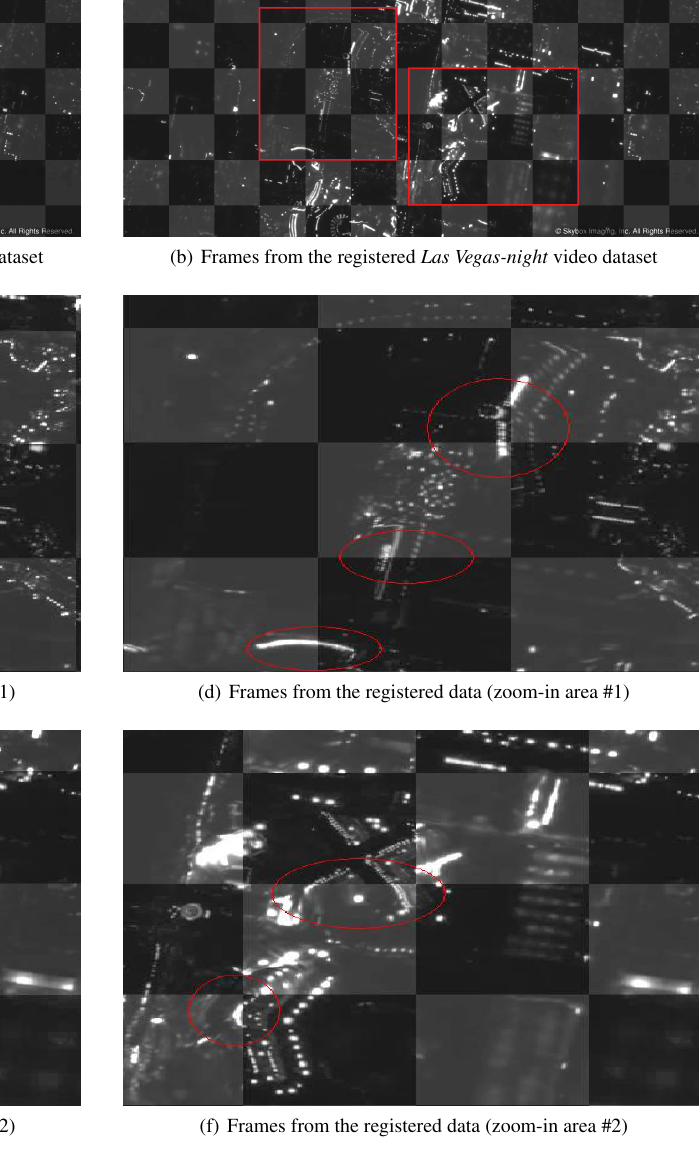
Figure 4: Chessboard visualization from the Las Vegas-night video dataset. Unregistered (left) and registered (right) data before and after the application of the proposed